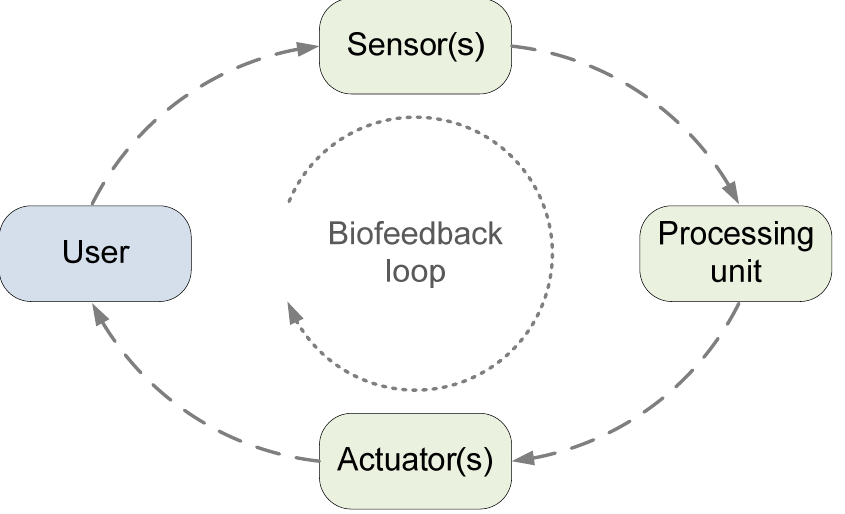
Figure 1. BMF system—Sensor(s) measure the user’s activity and send data to the processing unit. The processing unit analyses the data and generates feedback that is provided to the user via the actuator(s). The user responds to this feedback by correcting or changing their